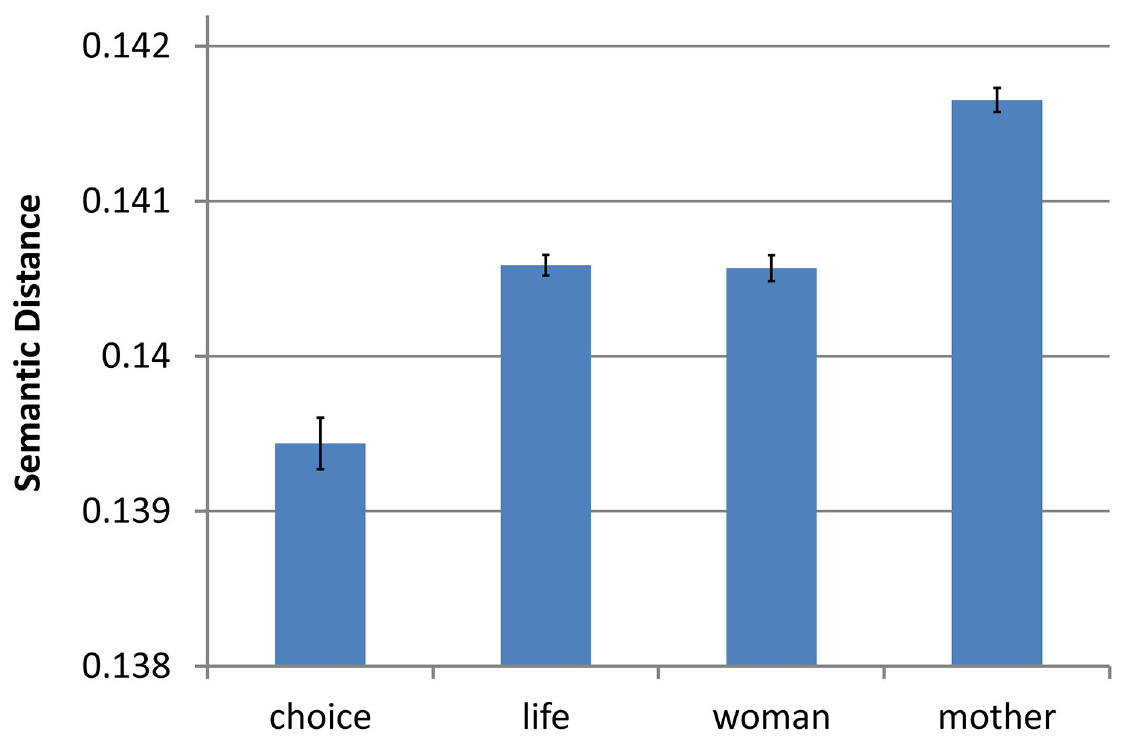
Figure 7. Mean context vector distances of choice , life , mother , and woman from abortion in the NYT. As the zero point of the graph represents identical uses for the term in question and abortion, lower positions in the graph represent greater relevance for the term as a frame of abortion . Data plotted is for all articles appearing in the New York Times for the years 1989-2006. Error bars represent standard